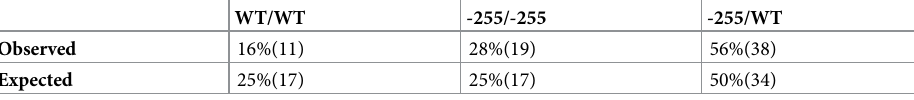
Table 1. Observed/Expected ratios of Nes enhancer deleted live born pups. WT/WT -255/-255 -255/WT Observed 16%(11) 28%(19) 56%(38) Expected 25%(17) 25%(17) 50%(34) p-value– 0.2437, chi-square value–